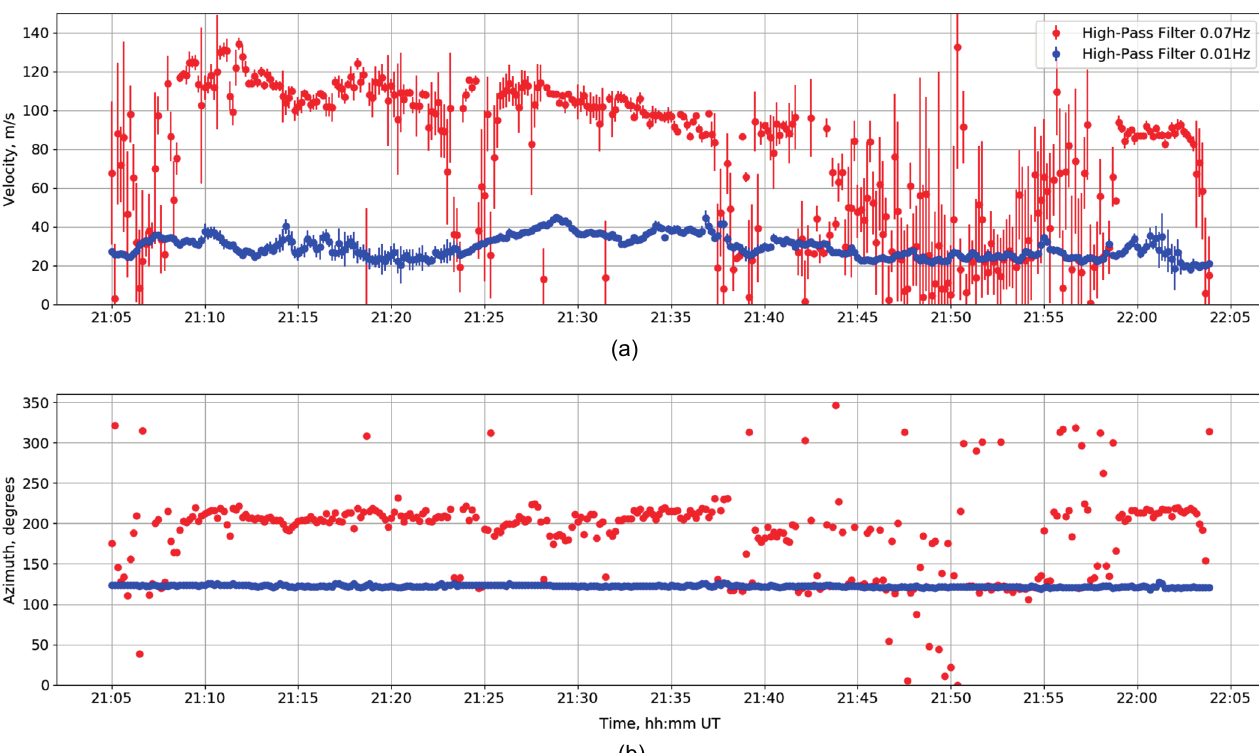
Fig. 9. (a) Velocities calculated for the fi rst hour of observation from cross-correlations created after fi ltering using the two different high-pass fi lter values. (b) Directions of these velocities, in degrees